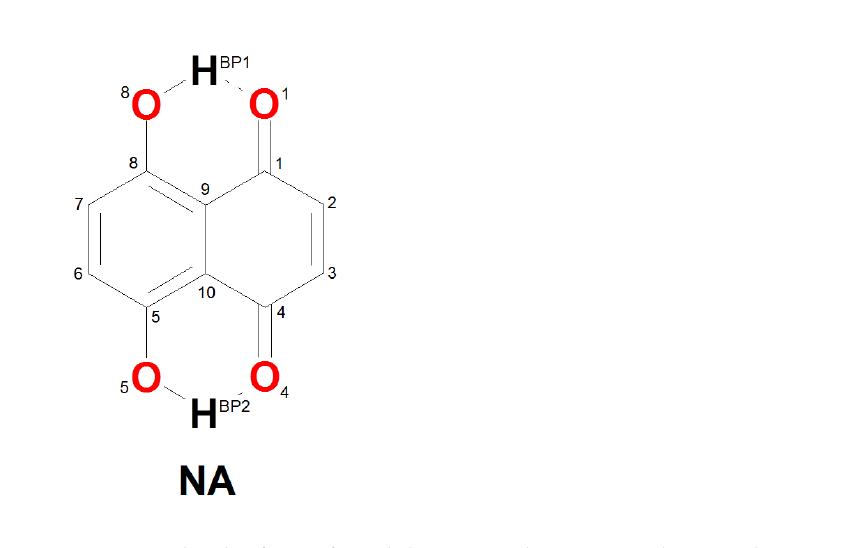
Figure 1. Molecular form of Naphthazarin with atoms numbering scheme applied in the study. The dotted lines indicate the presence of intramolecular hydrogen